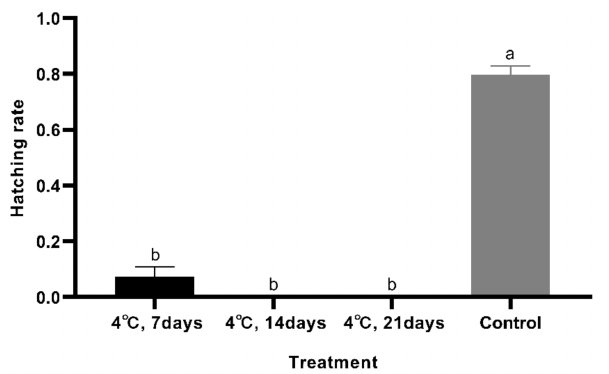
Figure 3. Difference analysis among the different treatments (4 ◦ C). Bars represent the standard error. The hatch rates of eggs stored at 4 ◦ C analyzed using Dunnett T3. Different letters on the bars indicate significant differences ( F 3,12 = 264.61; p < 0.05).